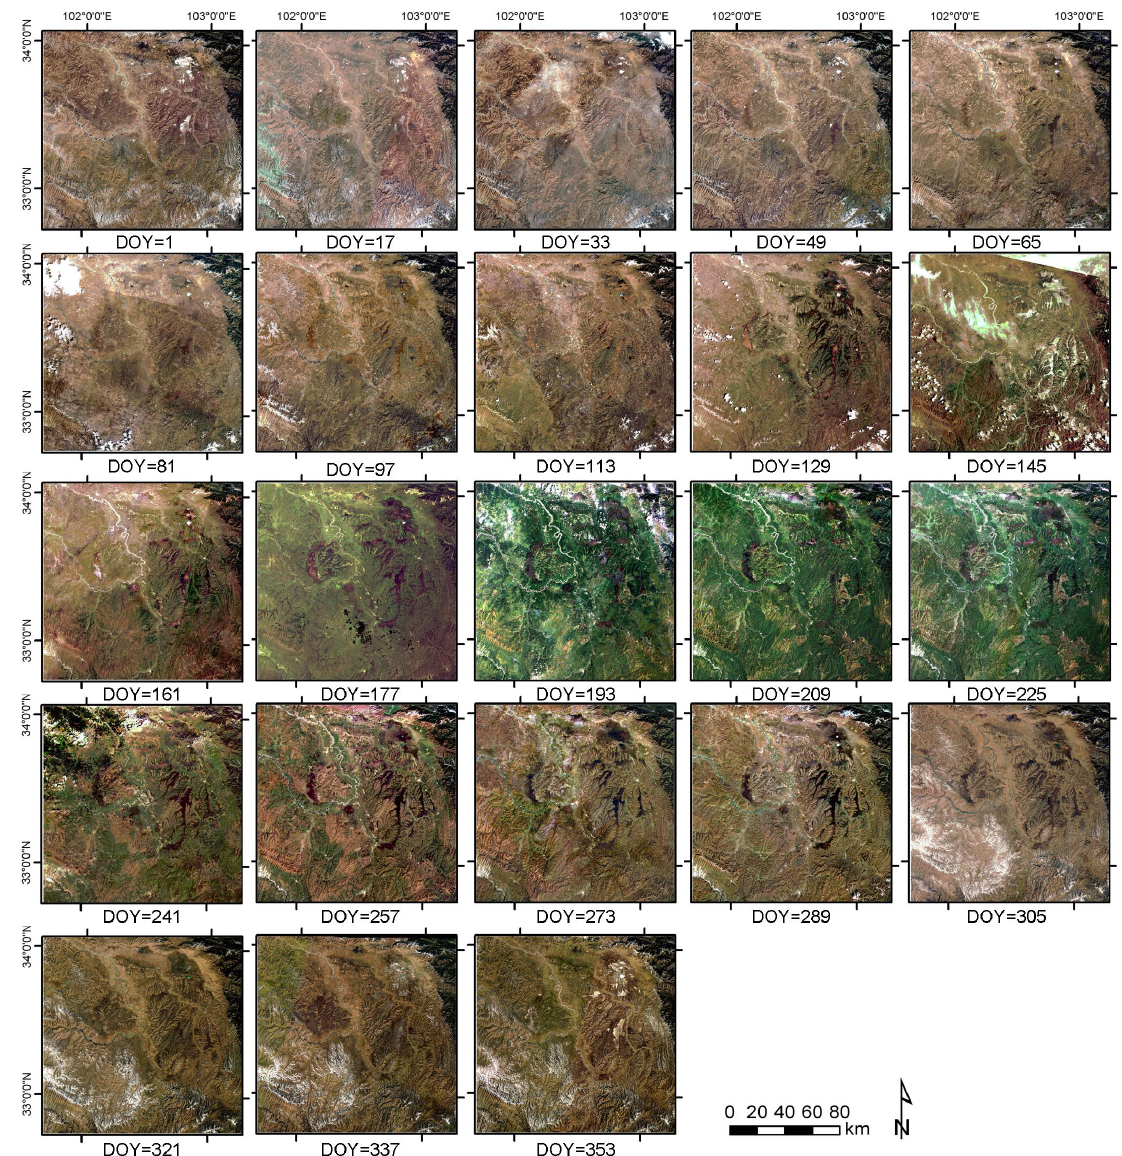
Figure 5. Browse images for the 16-day composited Top Of Atmosphere (TOA) reflectance results shown with bands 3, 2, 1 in red, green and blue. “DOY” means Day Of Year.